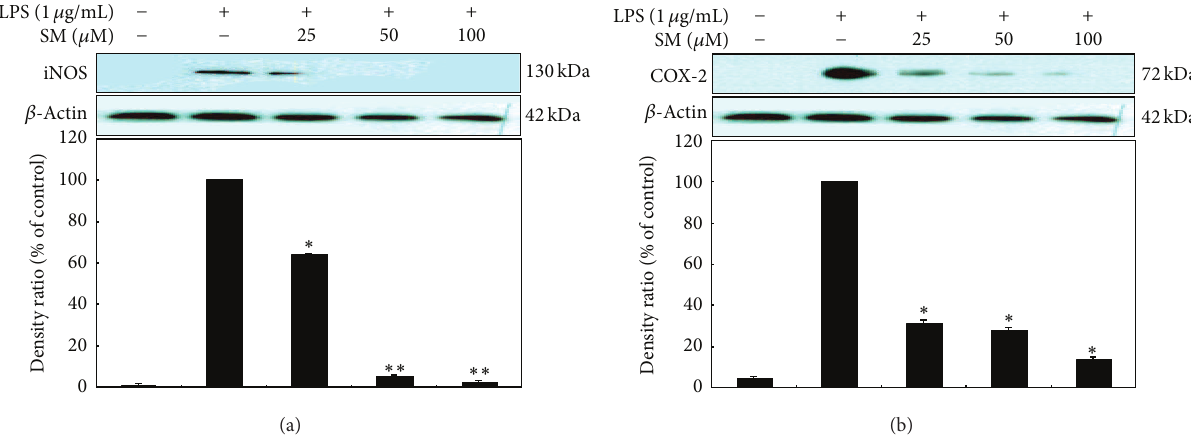
Figure 3: The effect of sargachromenol on the activation of iNOS (a) and COX-2 (b) in LPS-stimulated RAW 264.7 cells. RAW 264.7 cells (5.0 × 10 5 cells/mL) were stimulated with LPS (1 𝜇 g/mL) in the presence of SM at the indicated concentrations for 24h. Whole-cell lysates (25 𝜇 g) were prepared and subjected to 10% SDS-PAGE prior to the analysis of iNOS and 𝛽 -actin (loading control) expression by Western blotting. iNOS: inducible nitric oxide synthase; COX-2: cyclooxygenase-2; LPS: lipopolysaccharide; SM: sargachromenol; SDS-PAGE: sodium dodecyl sulfate-polyacrylamide gel